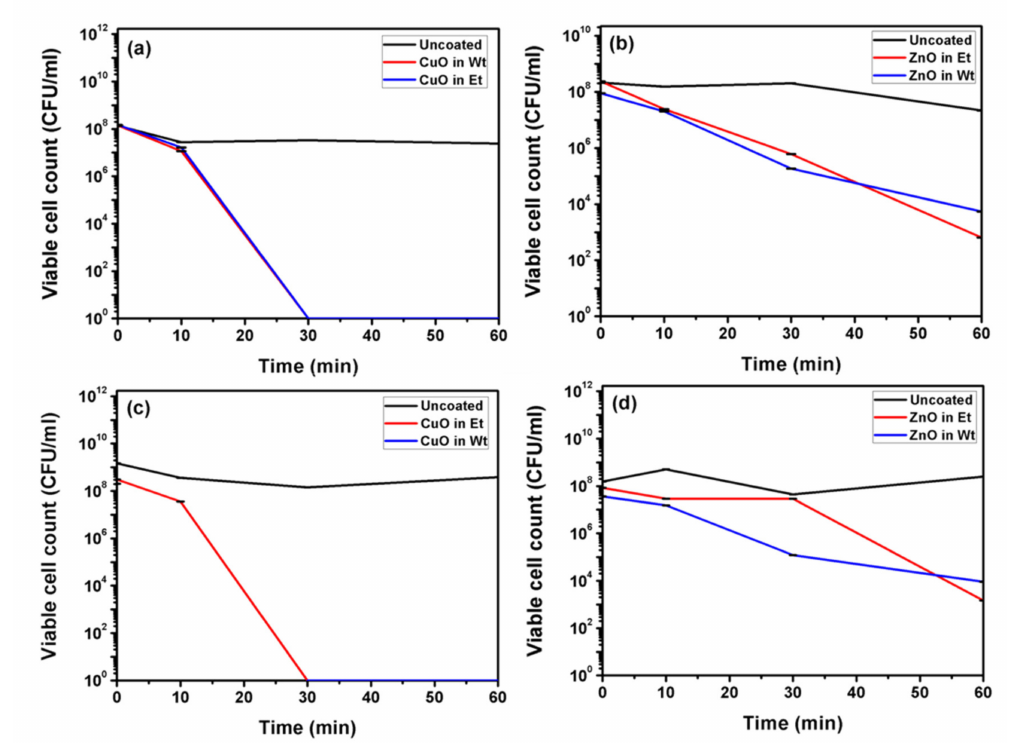
Figure 5. Antibacterial studies of CuO and ZnO NP-coated bandages in water or ethanol against S. aureus (Gram-positive) ( a , b ) and E. coli (Gram-negative) ( c , d ).